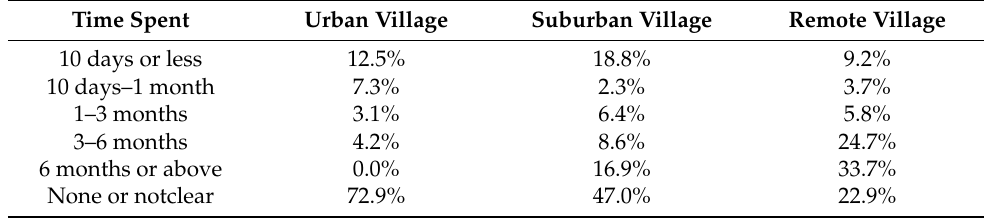
Table 7. The time that the elderly spend on farmland in rural villages. Time